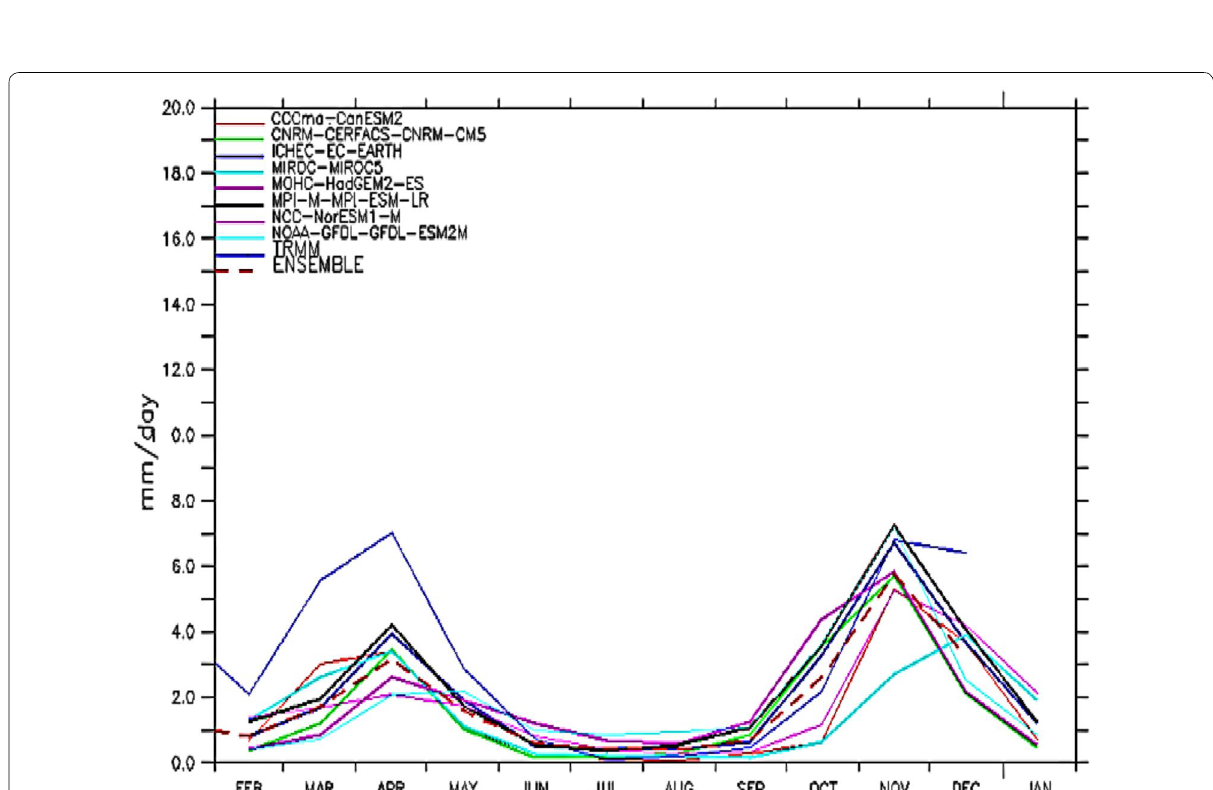
Fig. 3 CORDEX model assessment of the annual rainfall cycle, Garissa